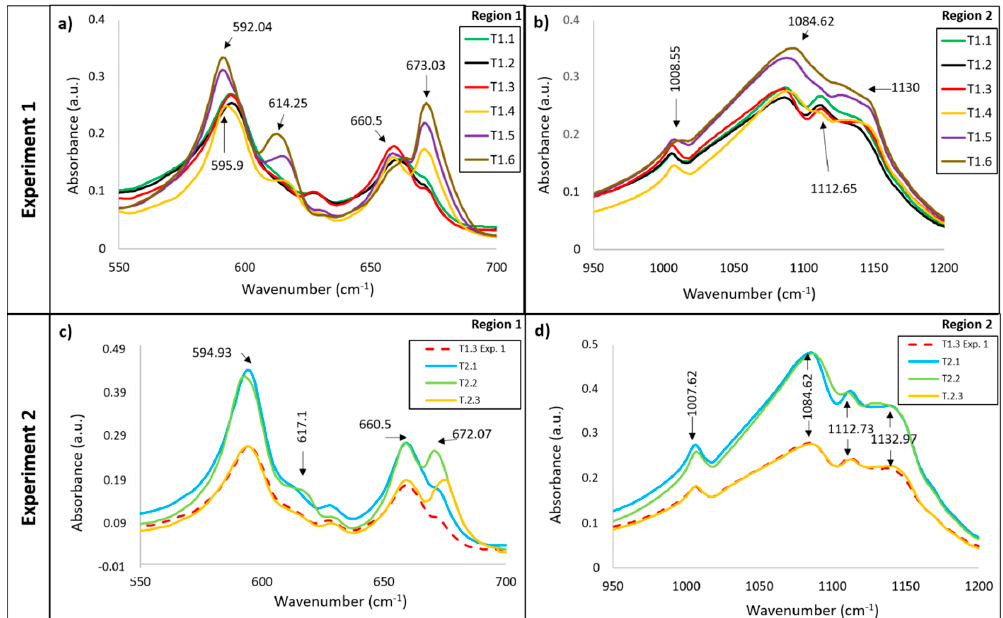
Figure 6. Image of the vibrations bands of SO 4 anion for the different testing points for both thermal treatments. ( a ) Infrared spectrum between 550–700 cm − 1 for Experiment 1; ( b ) Infrared spectrum between 950–1200 cm − 1 for Experiment 1; ( c ) Infrared spectrum between 550–700 cm − 1 for Experiment 2; ( d ) Infrared spectrum between 950–1200 cm − 1 for Experiment 2.